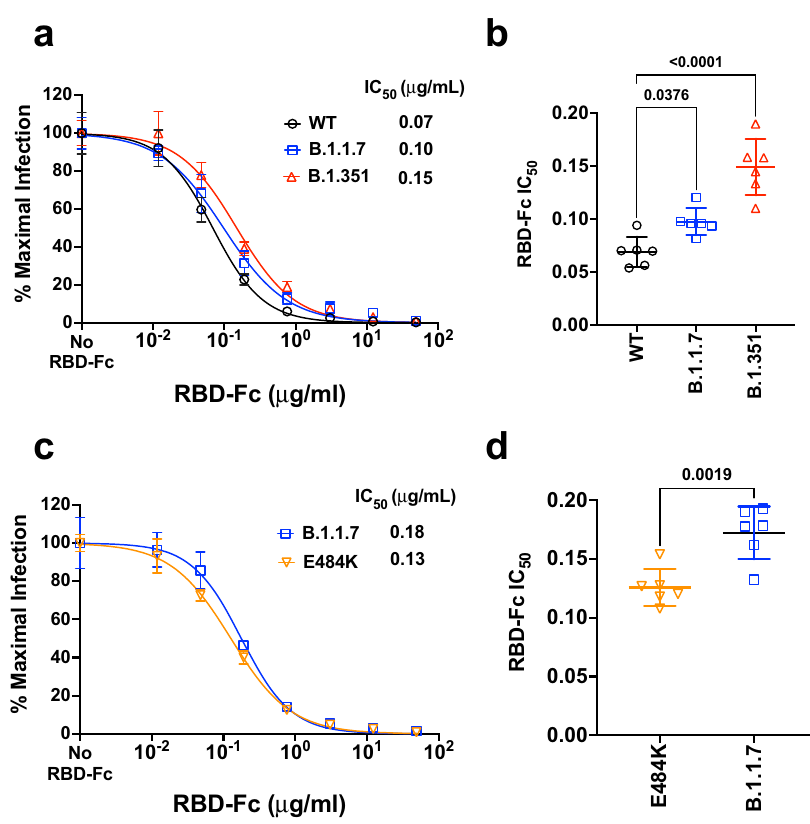
Fig. 5 Competitive inhibition of rcVSV-CoV2-S entry by soluble RBD-Fc. a Recombinant RBD-Fc was serially titrated with the infection inoculum containing a fi xed amount of rcVSV-CoV2-S bearing WT or the indicated VOC spike proteins. 10 hpi, GFP + cells were quanti fi ed by the Celigo image cytometer. Data points are means of six replicates with error bars representing standard deviation. The number of GFP + cells in the absence of any RBD-Fc was set to 100% and used to normalize the infection response in the presence of increasing amounts of RBD-Fc. Log[inhibitor] versus normalized response variable slope nonlinear regression curves were generated using GraphPad PRISM (v9.1.0). b The IC50 values from each replicate dose – response curve generated for a given virus were grouped. The mean (central bar) and standard deviation (whiskers) for each group are indicated. Adjusted p -values are indicated (ordinary one-way ANOVA with Dunnett ’ s multiple comparisons test are indicated). c is a repeat of the experiment done in a with the E484K mutant using a different preparation of recombinant RBD-Fc (see methods). B.1.1.7 serves as the common reference control. Data points are means of six replicates with error bars representing standard deviation. d The IC50 values were calculated as in b . The mean (central bar) and standard deviation (whiskers) for each group are indicated. Two-tailed p -value (0.0019) from an unpaired t -test is shown. Source data are provided as a Source Data fi